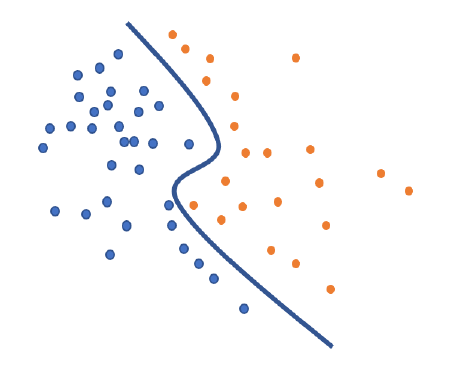
Figure 2. Visualization of classification